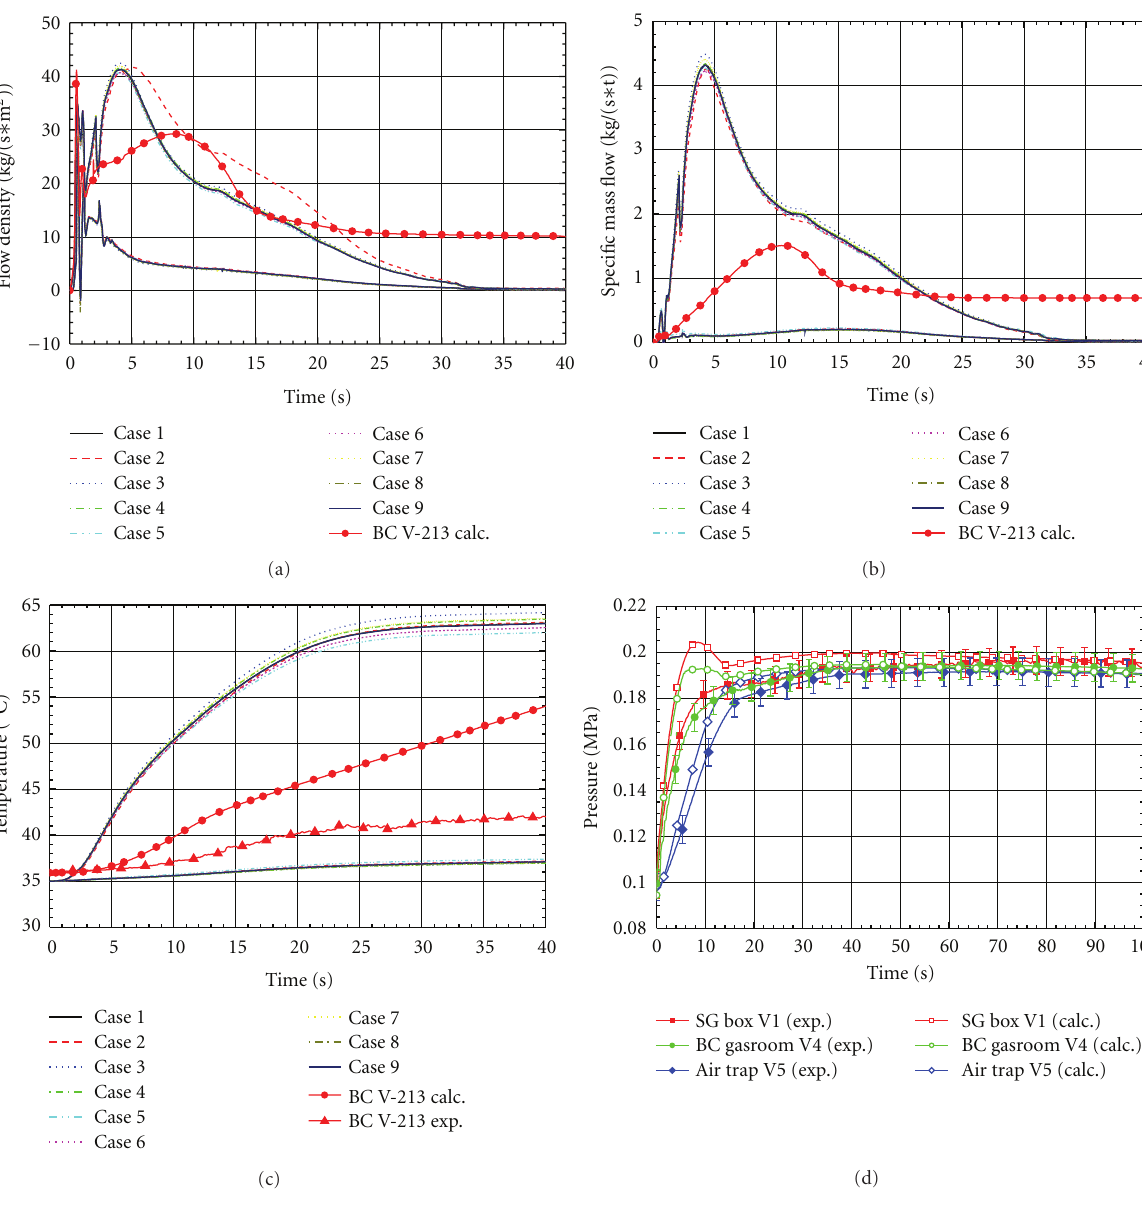
Figure 11: Comparison of posttest calculation of Test 1 and NPP bandwidth. (a) C1 criterion; (b) C2 criterion; (c) C3 criterion; (d) exper- imental and calculated absolute pressure in SG box V 1 , BC gasroom V 4 , and air trap V 5